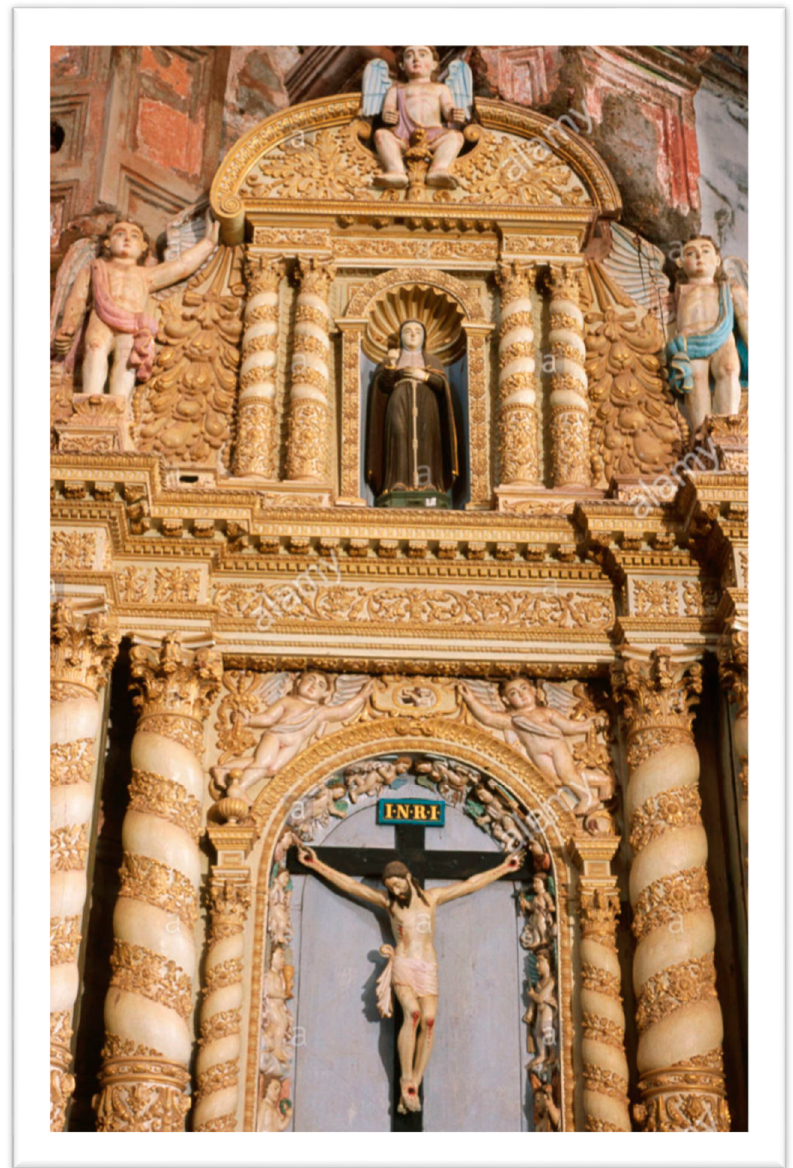
Figure 3. Gilded Carved Altar in the Church of St. Francis of Assisi (1661), detail, Old Goa